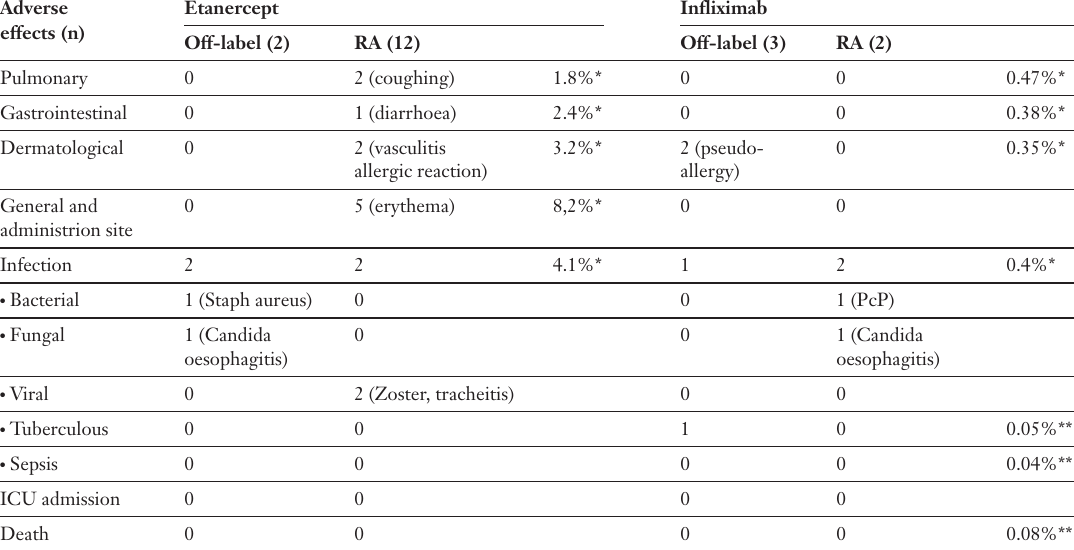
Adverse effects of the patients treated with etanercept (Enbrel ® ) or inflix- imab (Remicade ®